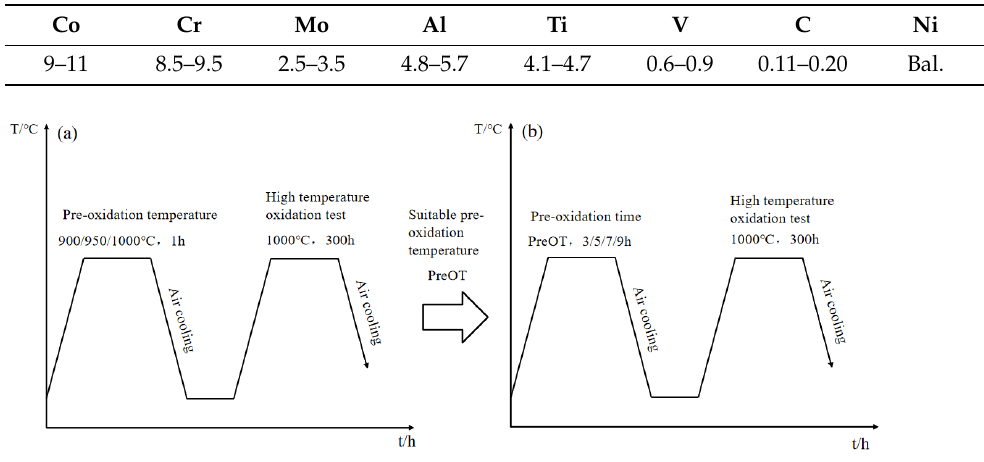
Figure 1. Experimental scheme of pre-oxidation process under high-temperature oxidation: ( a ) different pre-oxidation temperatures; ( b ) different pre-oxidation times.